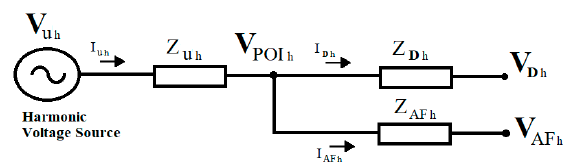
Figure 8. Simplified diagram of the active power filter application for series resonances.